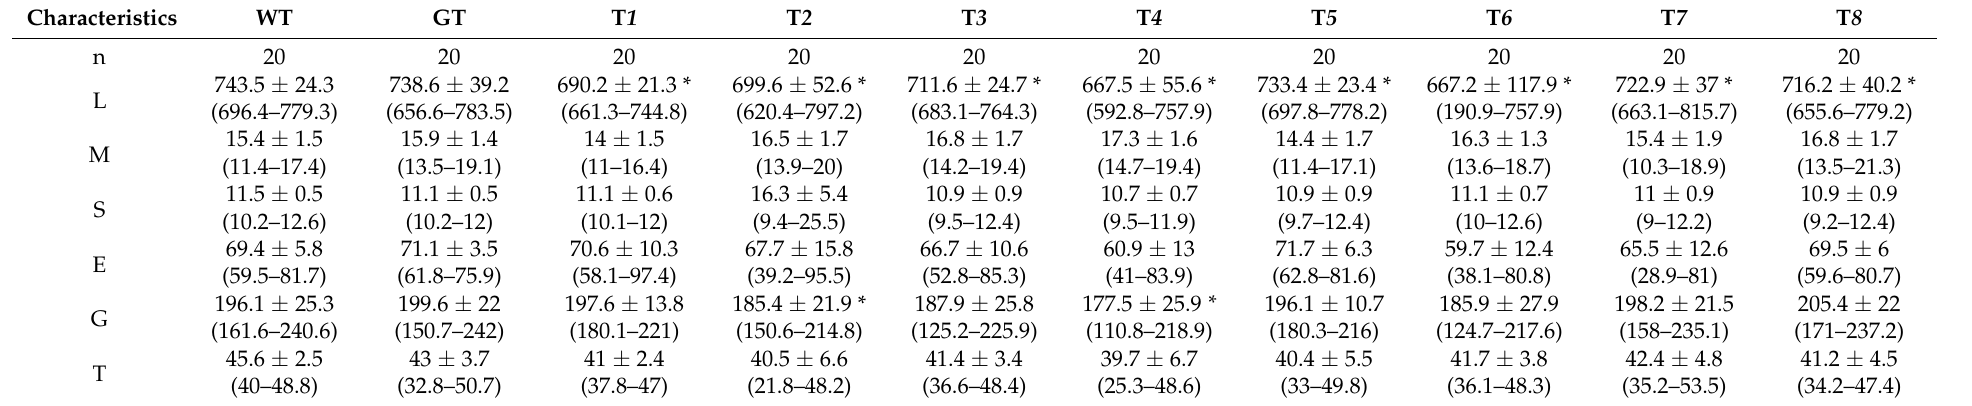
Table 3. Morphological characteristics of females in Aphelenchoides besseyi fed Ab-far-n hpRNA transgenic Botrytis cinerea